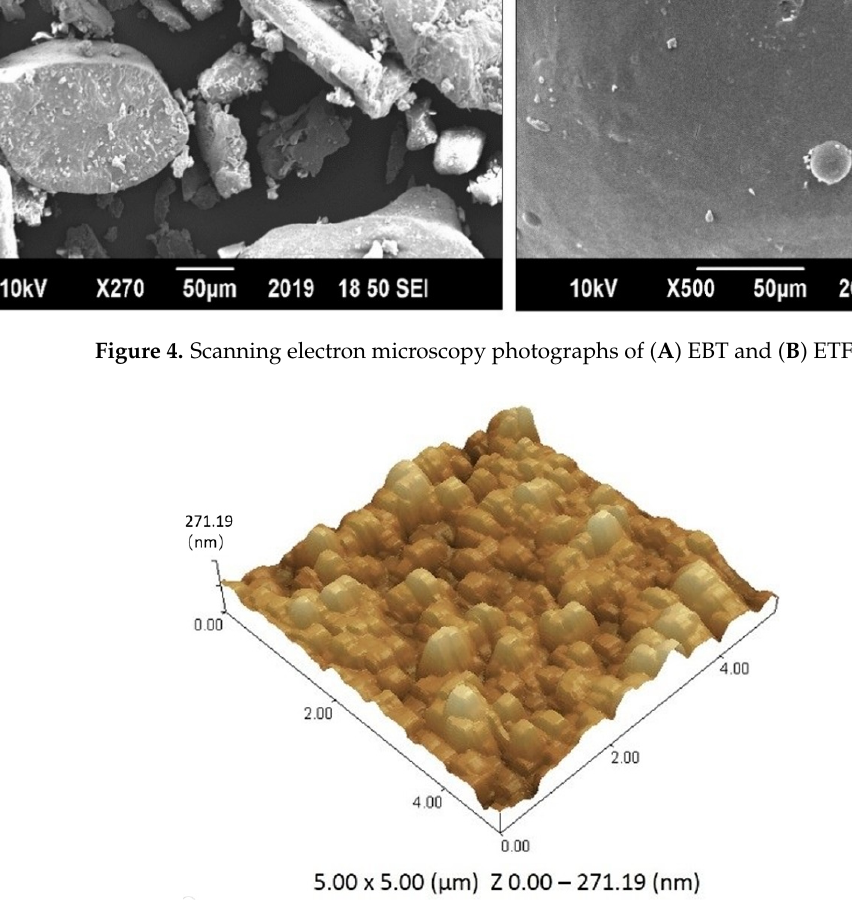
Figure 5. Illustration of surface morphology of optimized formulation (ETF-5) of transfersomes- loaded oral films (TOFs).